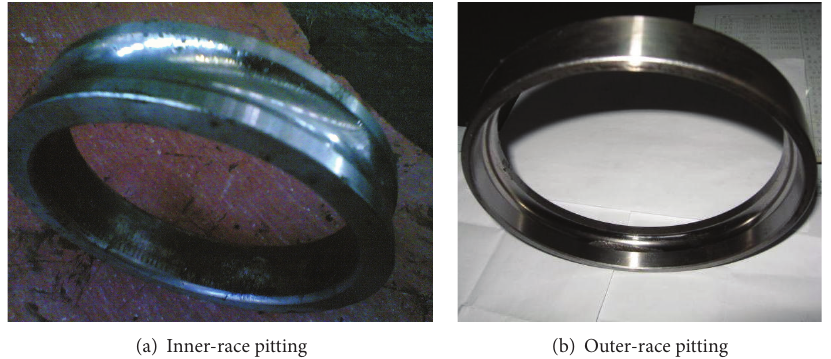
Figure 10: Pitting faults at the bearing of shaft I at the north of the speed-up